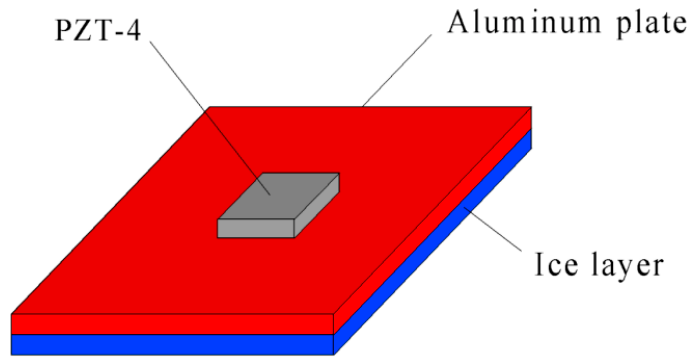
Figure 6. Sketch map of the adhesive position of the piezoelectric ceramic.